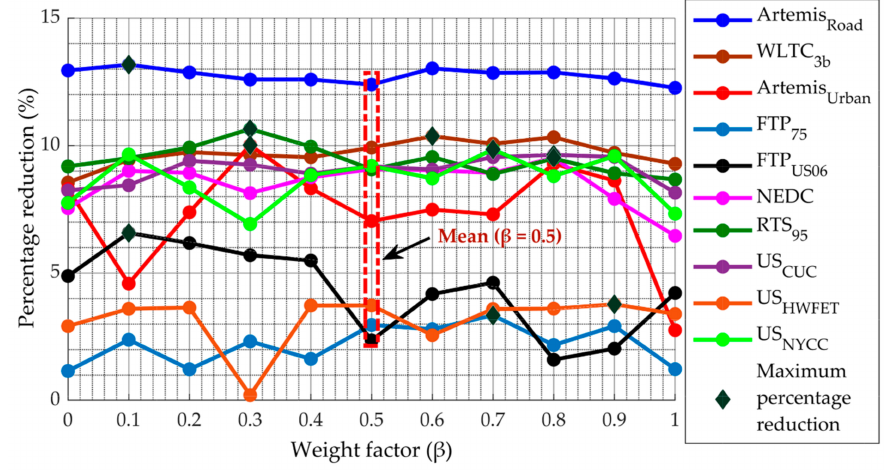
Figure 6. Percentage reduction in fuel consumption with respect to the initial driving cycle for various weight factors.